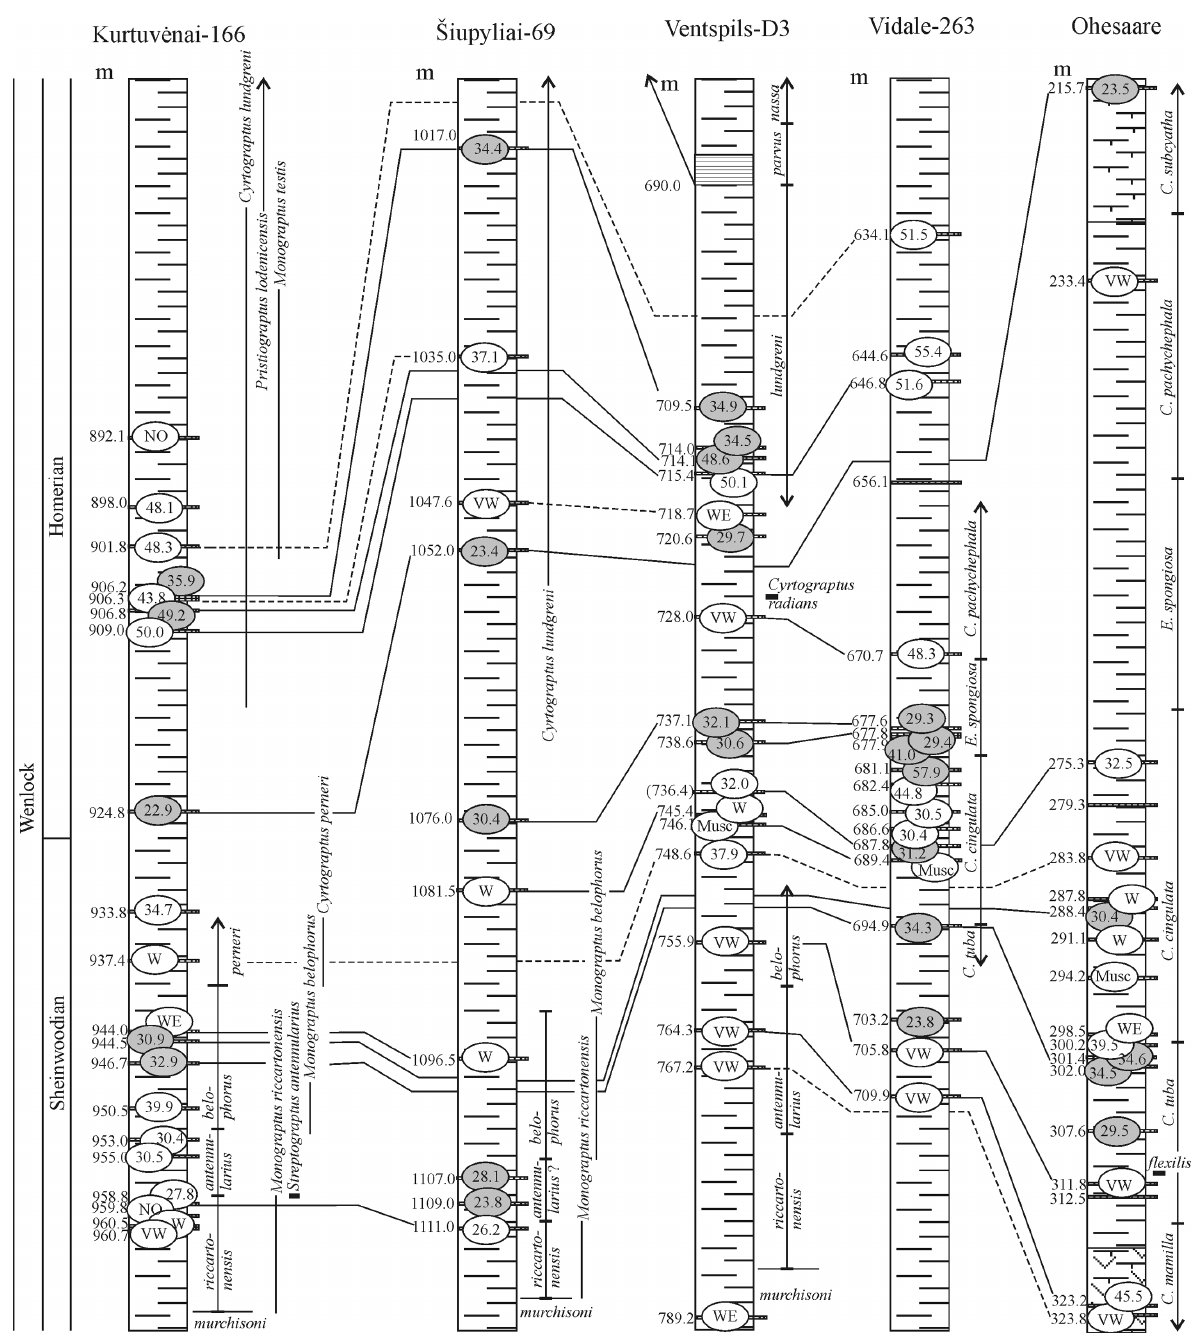
Fig. 5. Correlation of bentonites in the upper Sheinwoodian and lower Homerian. Distribution of graptolites in the Ventspils-D3 core from Gailite et al. (1987) and of chitinozoans from Kiipli et al. (2010a). For legend see Fig.